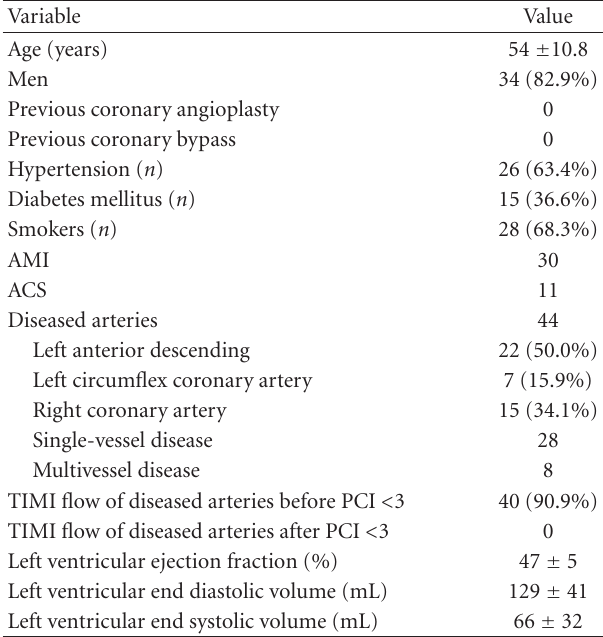
Table 1: Demographic and clinical characteristics of 41